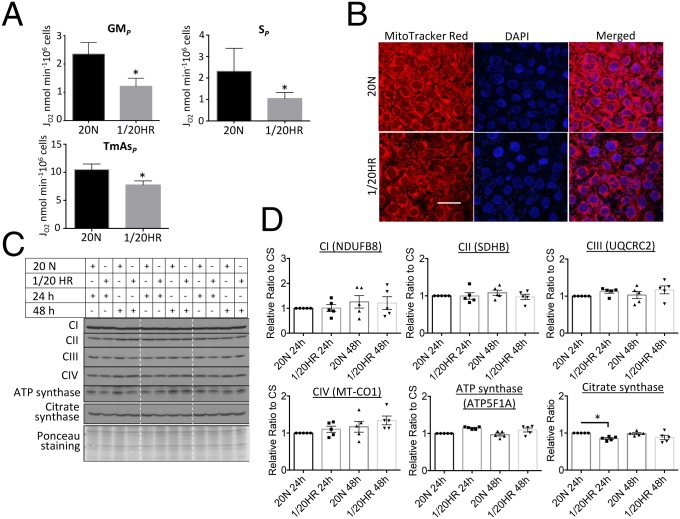
rHR recapitulates the mitochondrial changes observed in the PE < 34 wk placenta. BeWo cells were subjected to rHR for 48 h. (A) rHR reduces OXPHOS capacity supported by substrates for N-pathway via complex I (GMP), S-pathway via complex II (SP), and nonphysiological electron donors to complex IV (TmAsP). After addition of substrates, rate of oxygen consumption of cells was measured and data are presented as mean ± SEM, n = 4, *P < 0.05 (2-tailed paired t test). (B) rHR reduces mitochondrial membrane potential. Cells were stained with MitoTracker Red before being fixed, permeabilized, and stained with nuclear dye DAPI. Images were taken with confocal microscopy with 400× magnification. (Scale bar: 50 μm.) (C and D) Expression of ETC complexes subunits does not alter under rHR. The level of 5 ETC subunits was quantified using OXPHOS antibody mixture. Data were normalized to CS before expressing as a relative ratio to normoxic control, which was set as 1. Data are presented as mean ± SEM, n = 5. No significant change of all ETC complexes subunits (1-way ANOVA with Holm–Sidak's multiple comparisons test). The 20 N indicates cells were incubated under normoxic conditions with 20% O2 for 24 or 48 h; 1/20 HR indicates cells were exposed to a 6-h cyclic pattern of 1% and 20% O2 for 24 or 48 h.